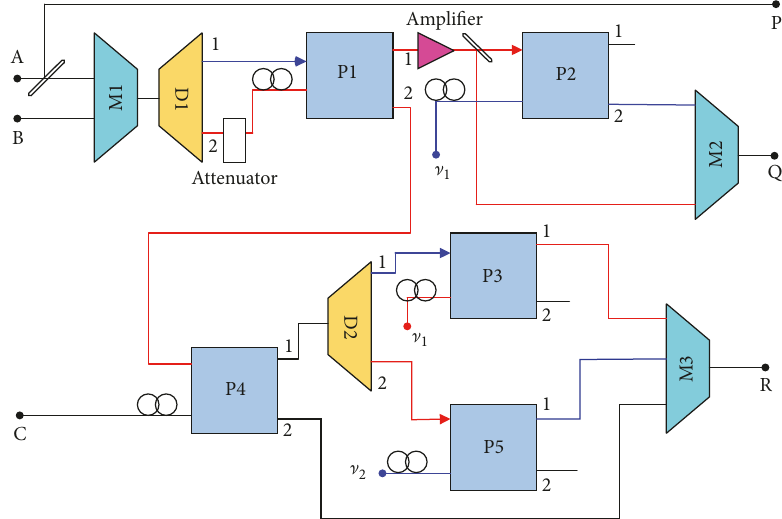
Figure 7: Scheme of optical Peres gate using PSWs.